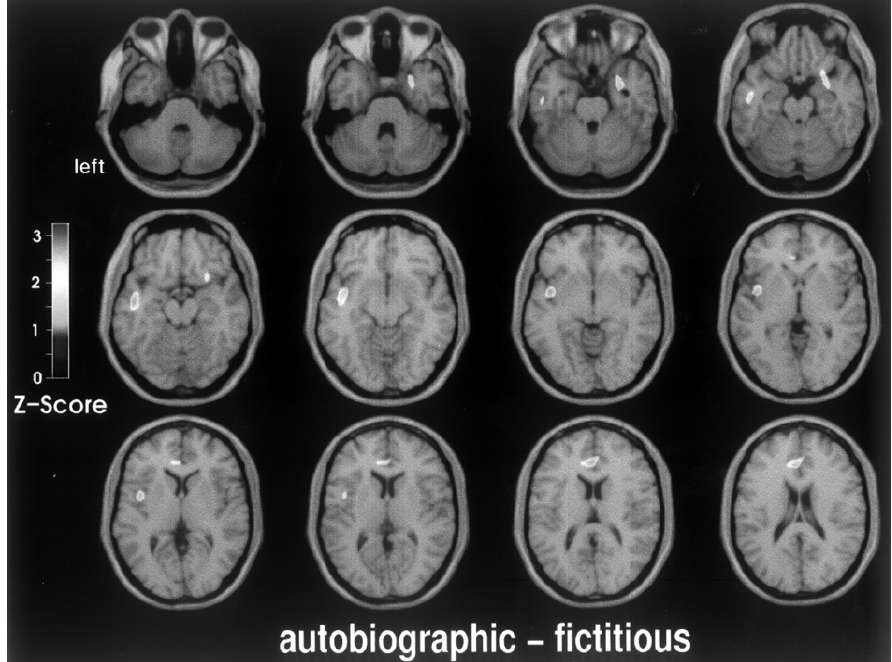
Functional anatomy of temporal activations during affect-laden autobiographic memory retrieval (comparison AUTOBIO- GRAPHIC-FICTITIOUS). The SPM-map is sectioned in transverse planes and is displayed on top of an arbitrary magnetic resonance image that has been normalised spatially to the same anatomical space. The color bar indicates the Z statistics achieved. The activations are found in the regions of the right amygdala and uncus, including the place where the uncinate fascicle passes on its way between the anterior temporal and the inferior prefrontal cortex. In the first row, the 1st, 2nd and 3rd sections (from left to right) show amygdaloid activation spots: 30 0 − 20; 26 0 − 26, the 4th section the activation spot in the ventral prefrontal cortex near the uncinate fascicle: 26 16 − 12. Activations in the left middle and superior temporal lobe are visible in the 3rd and 4th section of the top row, in all sections of the medial row and in the 1st and 2nd section of the bottom row; activation spots: − 50 − 12 − 10; − 44 2 10; − 46 − 2 − 2. The activations in the anterior cingulate cortex can be seen in the 4th section of the middle row and in all bottom sections; activation spots: − 4 34 24; − 6 36